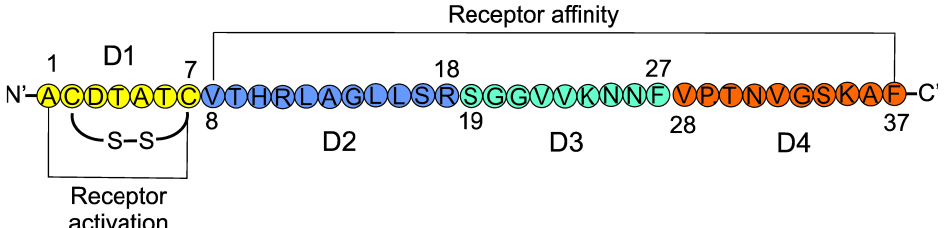
Figure 4. Linear representation of the calcitonin gene-related peptide with its four domains (D1 – D4) marked in different colors. Amino acids are denoted according to the one-letter code. Numbers indicate the positions of amino acids from the N-end. The N- and C-terminals are denoted with primed letters to distinguish them from amino acid symbols.